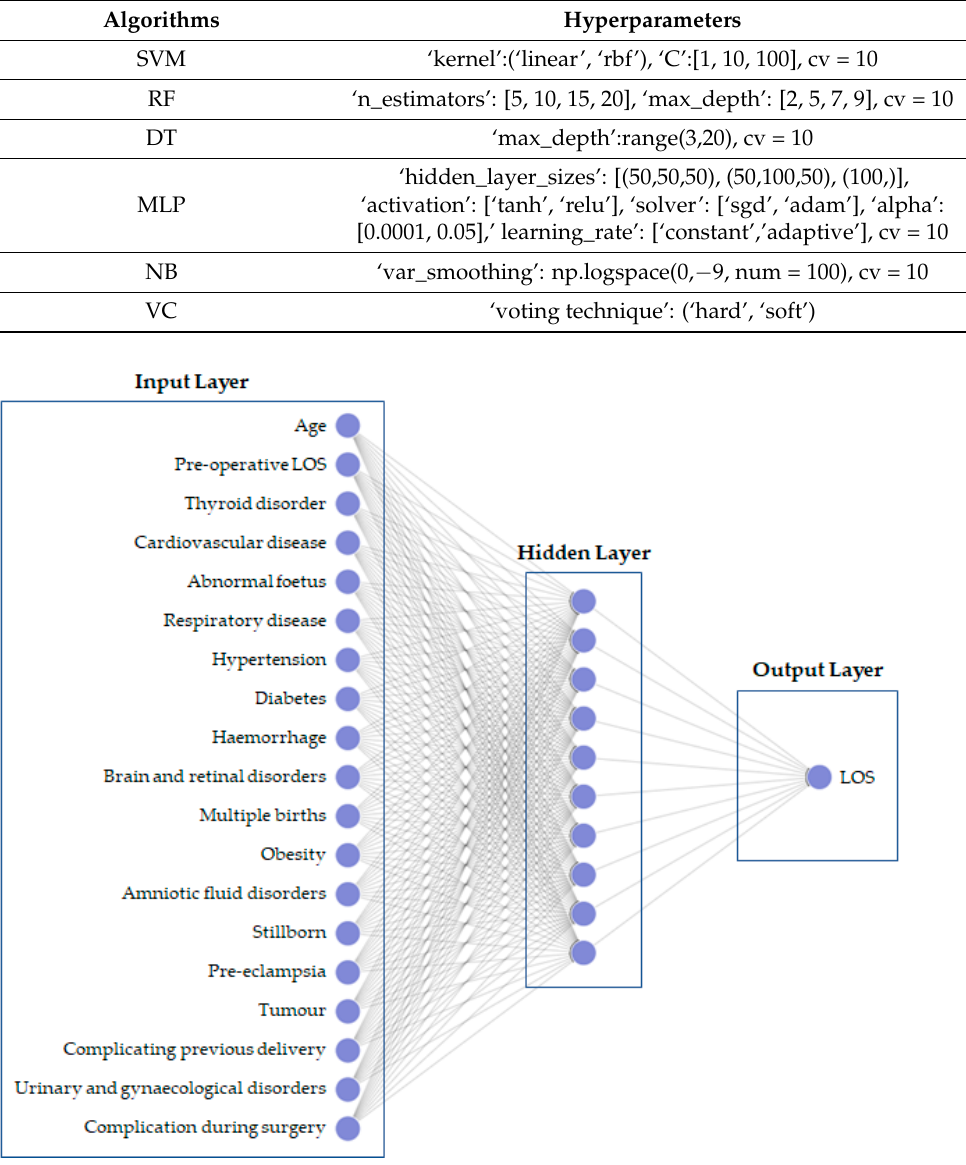
Table 1. Hyperparameter selection for each artificial intelligence model.